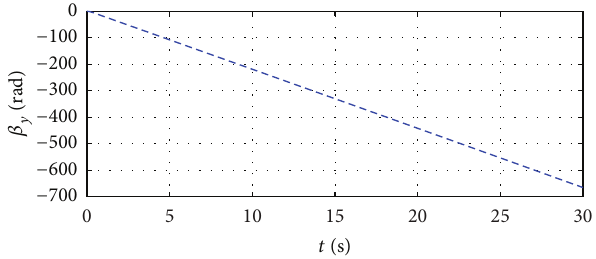
Figure 9: Beta in 𝑦 direction. Beta in 𝑦 direction is plotted versus time in 30 seconds as shown in the figure.